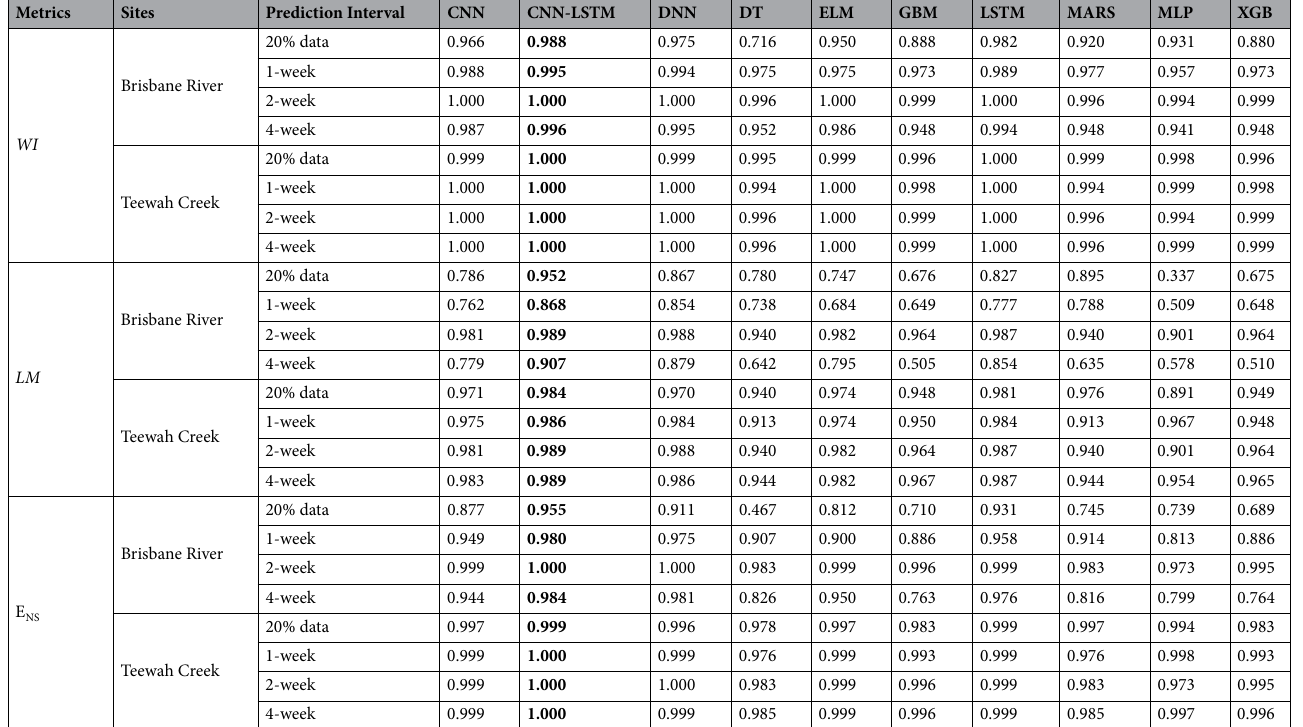
Table 5. Performance evaluation of CNN-LSTM model with the comparative counterpart models: Convolutional Neural Network (CNN) and Long Short Term Memory Network (LSTM) as well as the Deep Neural Network (DNN), Multi-Layer Perceptron (MLP), Extreme Learning Machine (ELM), Gradient Boosting Regression (GBM), Decision Tree(DT), Multivariate Adaptive Regression Splines (MARS) and Extreme Gradient Boosting Regression (XGB) model as measured by Willmott’s index (WI), ) Legates and McCabe’s Index (LM) and Nash–Sutcliffe Coefficient (E NS ) in the testing phase for hourly streamflow (Q, m 3 s −1 ) prediction. Prediction was done for 1-hour horizon for 20% of total data (9-Months), 1-Week (1W), 2-Week (2W) and 4-Week (4W) Best Model is highlighted in